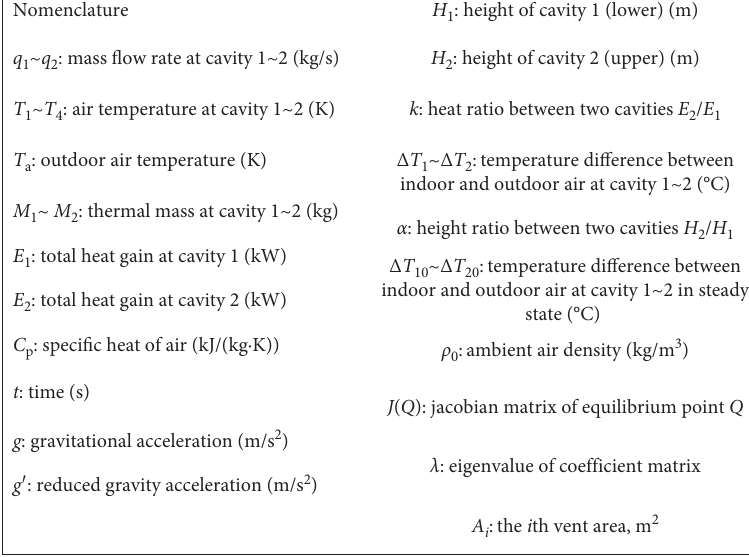
Figure 1: Nomenclature of variables and constants.